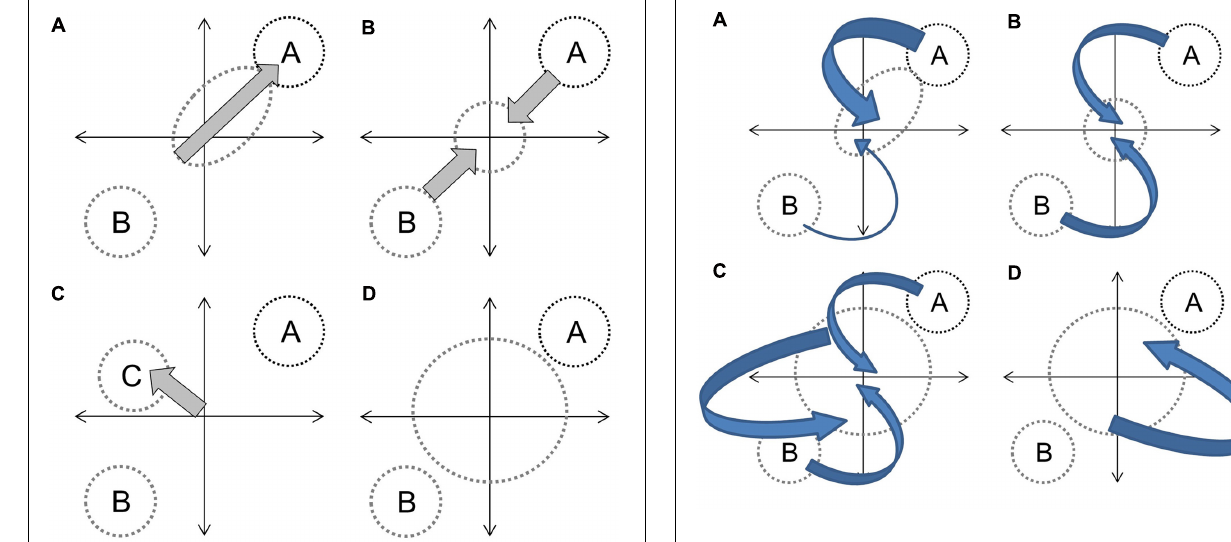
FIGURE 2 | Demography effects on hybrid phenotypes. Independent of selection, large contributions of species A relative to species B to future generations would skew the hybrids toward species A (A) . Equal contributions between species A and B to future generations would pull the hybrid pool equally in both directions (B) . Breeding among hybrid generations and parental species would increase variability with some directionality toward progenitors (C) . Breeding solely among hybrids would increase variability independent of progenitor phenotypes (D) . Arrow size indicates size of genetic